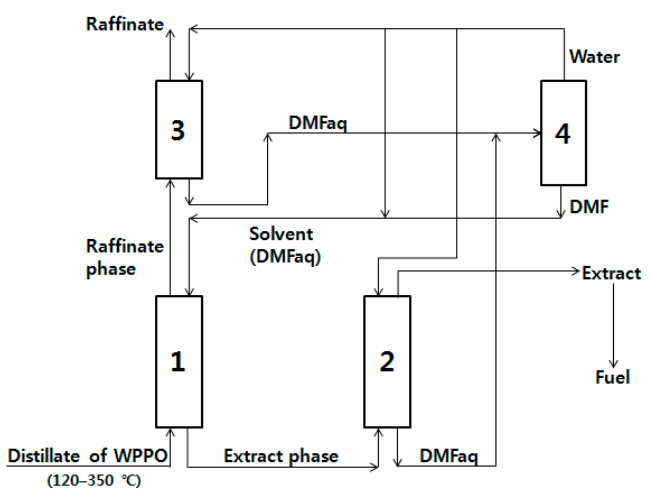
Figure 6. Enrichment process of paraffin components in distillate of WPPO. Tower no. 1: extraction tower, Tower no. 2: stripping tower, Tower no. 3: washing tower, Tower no. 4: distillation tower.